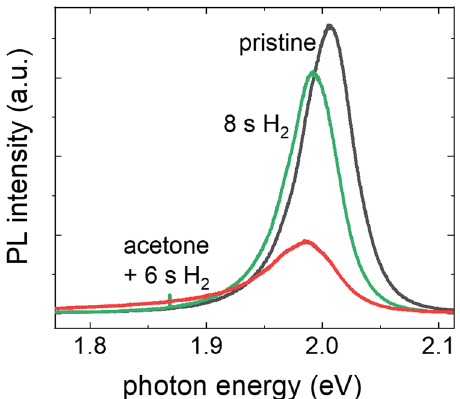
Fig. 4 After PMMA removal with a hydrogen plasma strip (8s H 2 plasma), the PL spectra show only a minor change as